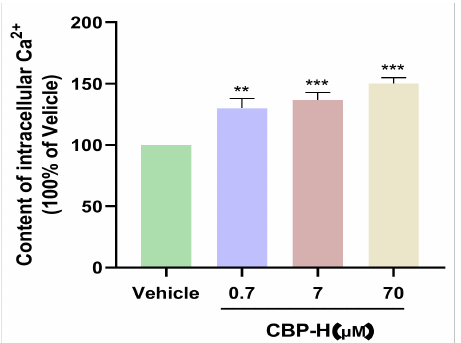
Figure 7. The changes in the intracellular calcium concentration in MC3T3-E1 cells after 0.7, 7, and 70 µ M CBP-H treated. ** p < 0.01, and *** p < 0.001 vs.